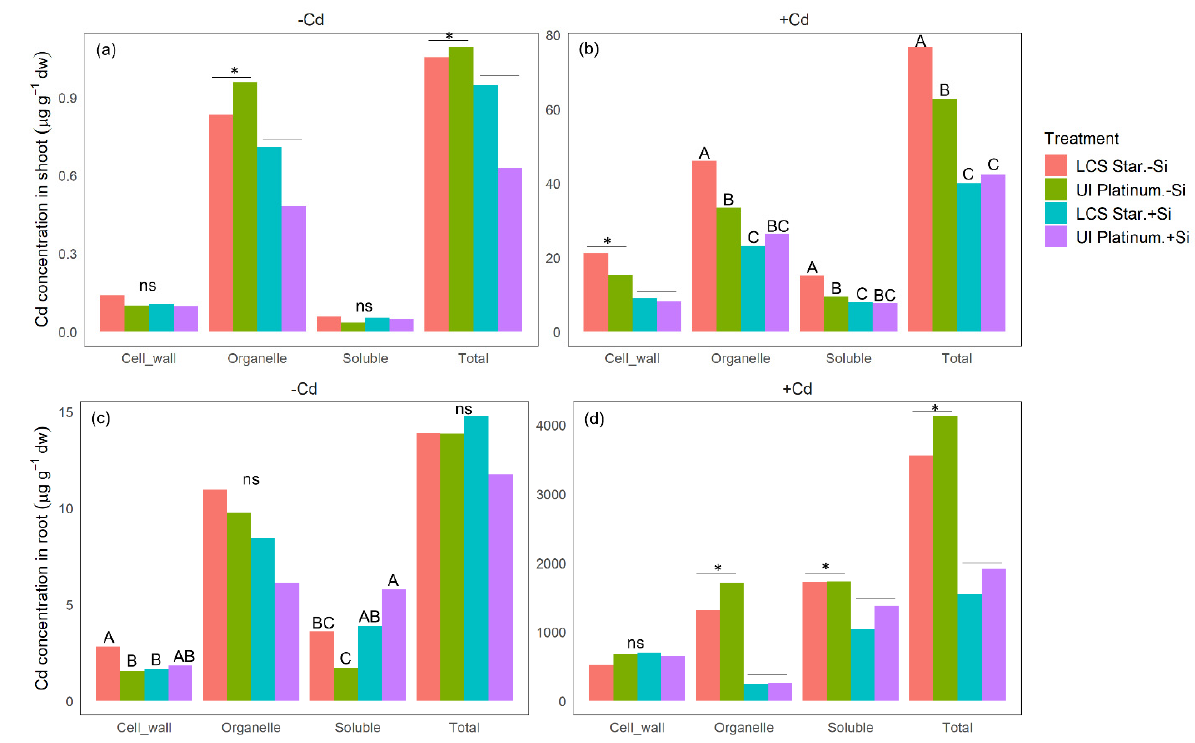
Figure 2. Subcellular distribution (i.e., cell wall, organelle, and soluble fractions) of Cd in the shoot ( a , b ) and root ( c , d ) of LCS Star and UI Platinum in response to Si and Cd treatments. Different letters indicate significant differences in cultivar × Si level at α = 0.05. The symbol “*” indicates significant differences between Si levels at α = 0.05. “ns” represents insignificant differences.